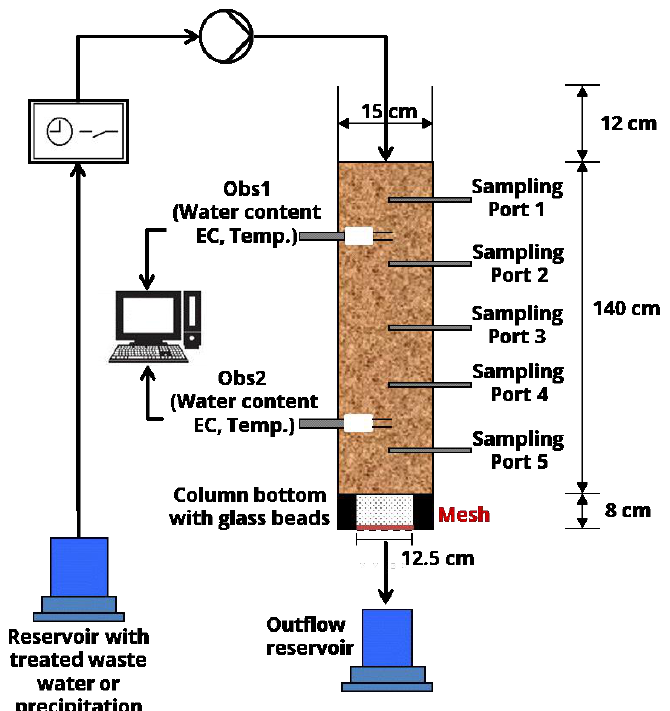
Figure 1. Set-up of 1D-column experiment.